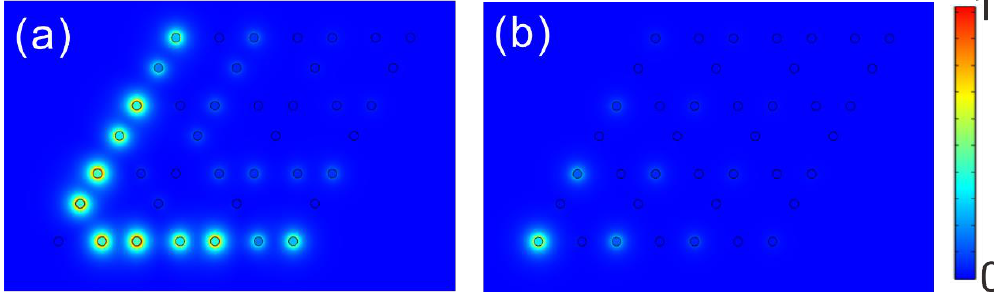
Figure 5. The typical mode profiles ( | E | ) in rhombic nanowires. ( a ) Edge mode and ( b ) corner mode.